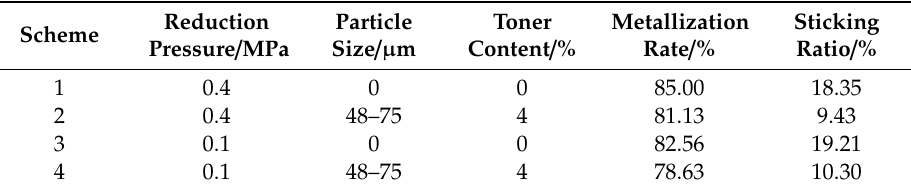
Table 3. Pre-experimental schemes and